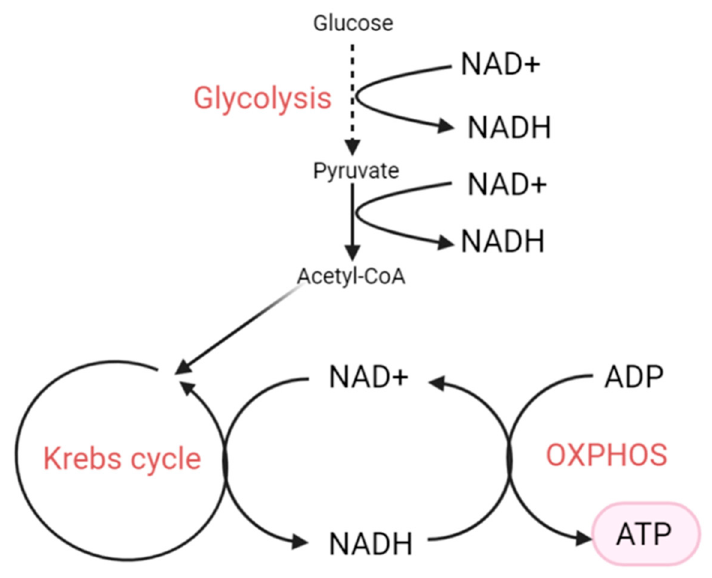
Figure 2. NAD + (H) redox involvement in ATP